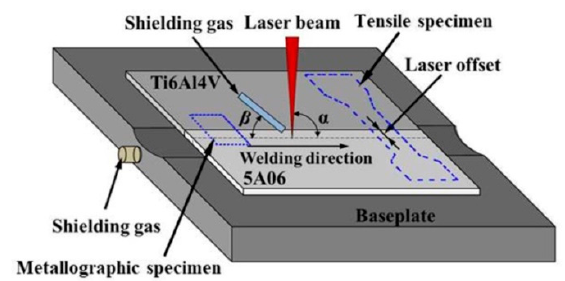
Figure 1. Schematic diagram of welding process.